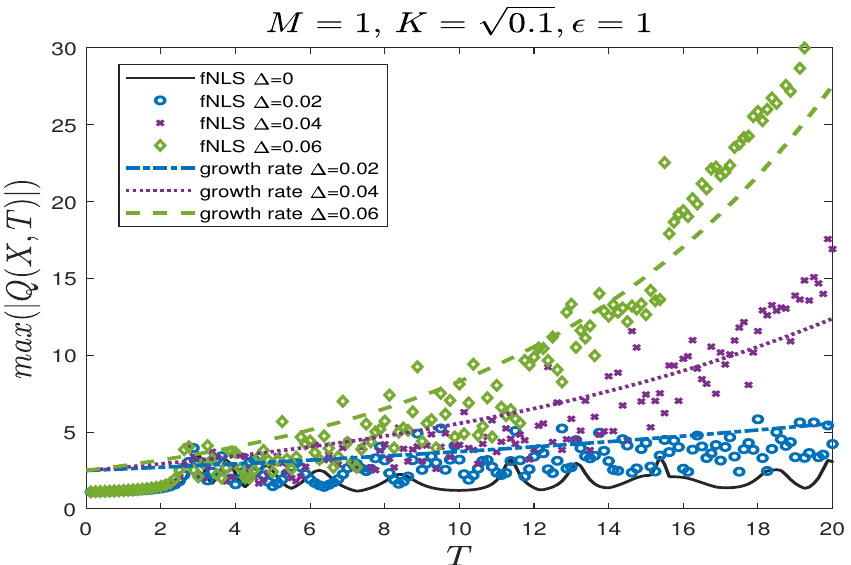
Figure 19. Case 4: The initial condition is (14). Maximum of | Q ( X , T ) | and growth rate 2 ∆ when √ M = 1.0, (cid:101) = 1.0, K = 0.1 for various values of ∆